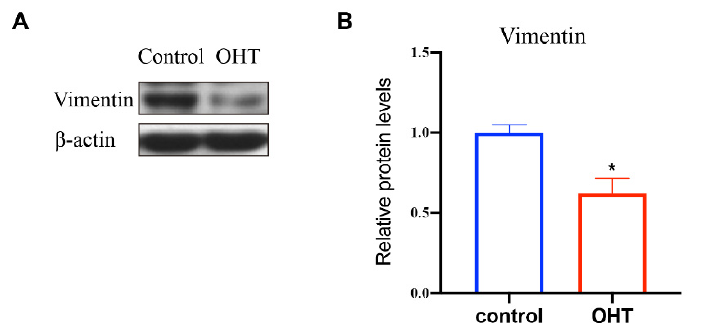
Figure 6. Effects of OHT on the expression of vimentin in TM cells. ( A ) The bands of vimentin. Analysis of the bands was performed using Image J. ( B ) Quantification analysis of the expression level of vimentin. TM cells in the OHT group showed significantly decreased level of vimentin compared with control cells based on western blot analyses. * p < 0.05.